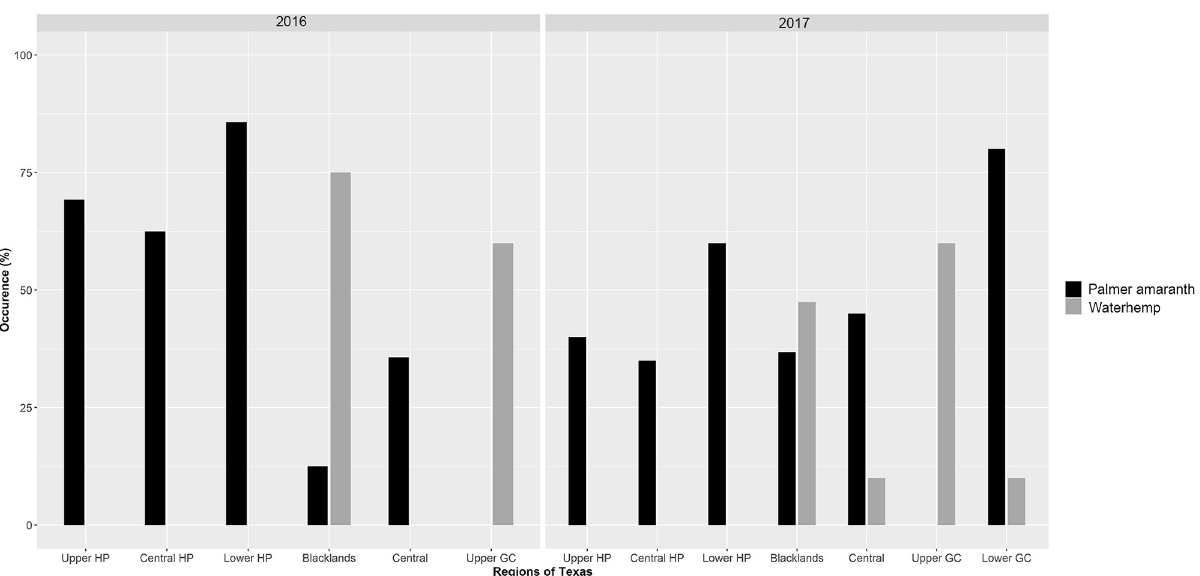
Fig 2. Percent of surveyed fields infested with A . palmeri and A . tuberculatus escapes in the major cotton-producing regions in Texas in 2016 and 2017. The Lower GC region was surveyed only in 2017. Abbreviations: HP, High Plains; GC, Gulf Coast.